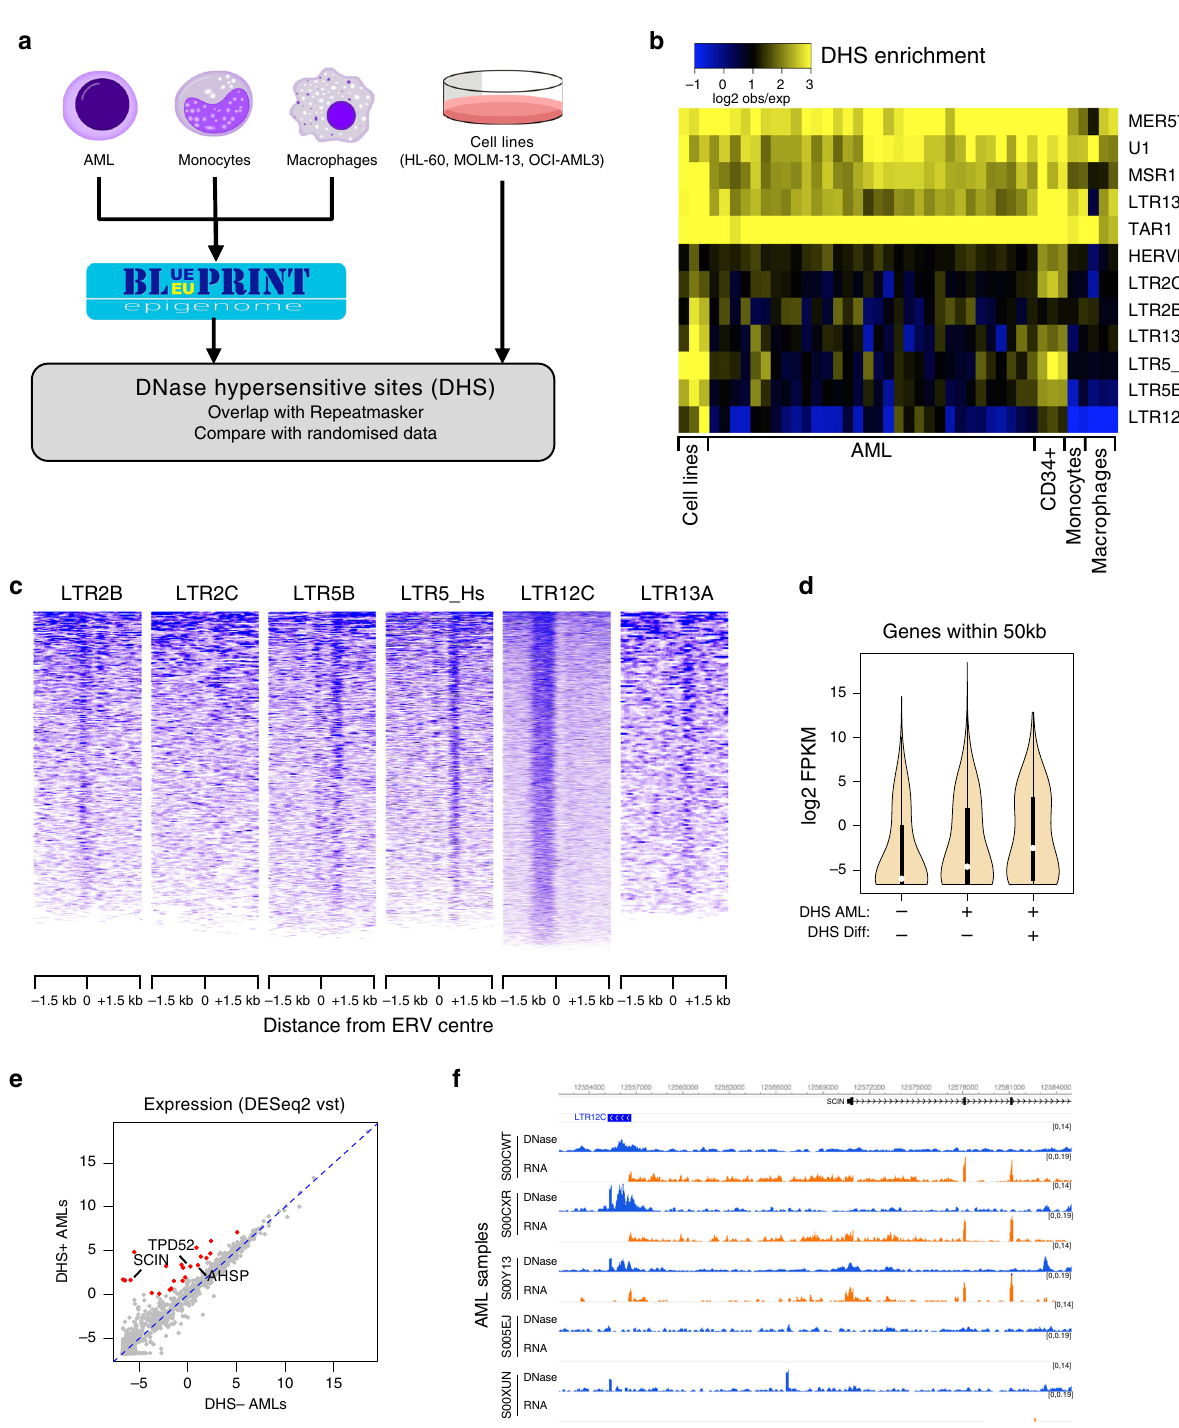
Fig. 1 ERVs with regulatory potential are activated in AML. a Schematic of the strategy to detect repeat families associated with open chromatin in AML (hematopoietic cells ’ credit: A. Rad and M. Häggström; CC-BY-SA-3.0 licence). b Heatmap of the observed/expected enrichment for DHSs in selected repeat families. Cell lines are presented in the following order: HL-60, MOLM-13 and OCI-AML3. c DNase-seq pro fi le across all elements of each AML DHS-associated repeat (A-DAR) families in OCI-AML3. d Gene expression average across all Blueprint AML samples for genes within 50 kb of A-DARs with or without a DHS in AML and/or in differentiated cells (boxes indicate fi rst, second (median) and third quartiles; whiskers indicate data within 1.5× of the interquartile range). e For each gene lying near an A-DAR element, we compared its expression in AML samples ( n = 26) where the respective ERV has a DHS, versus AML samples where the DHS is absent. Expression values were normalised using the variance-stabilising transformation (vst, log2 scale) in DESeq2. Highlighted are genes with >4-fold difference and vst > 0. f Example of a gene ( SCIN ) that displays a strict correlation between its expression (orange) and the presence of a DHS peak (blue) at a nearby LTR12C element in different AML